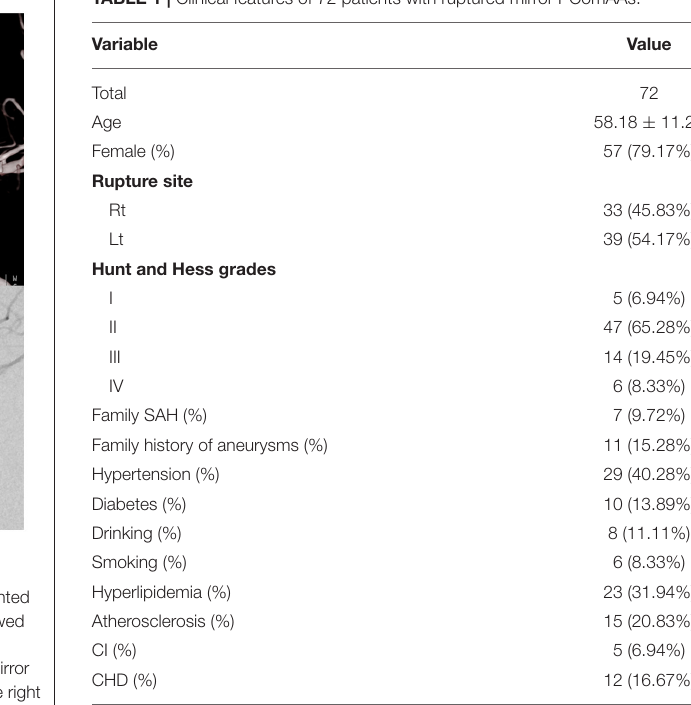
TABLE 1 | Clinical features of 72 patients with ruptured mirror